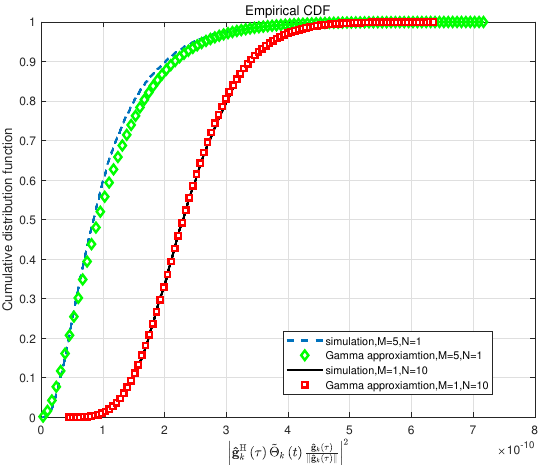
Figure 2. Cumulative distribution function of signal power with MRT precoder under different M and N